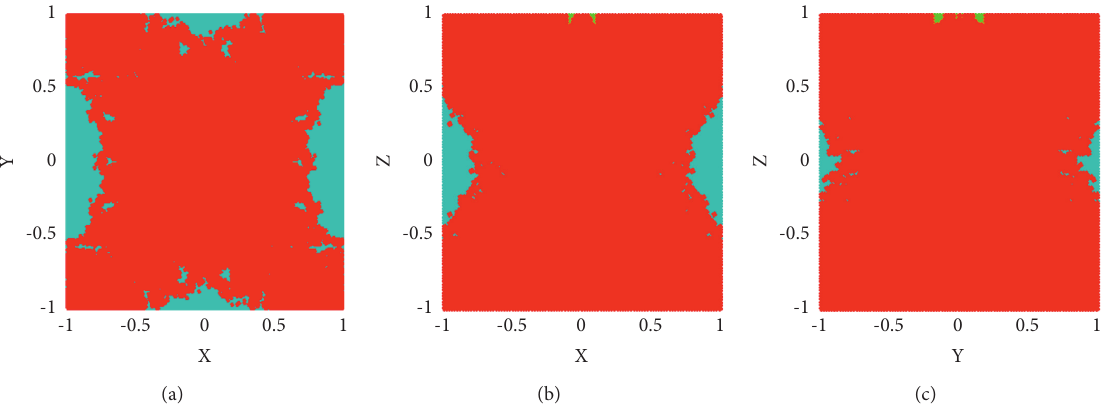
Figure 7: Initial values for various dynamics of the proposed oscillator in (a) X - Y plane, (b) X - Z plane, and (c) Y - Z plane. The oscillatory region is cyan, the equilibrium points are red, and the unbounded points are